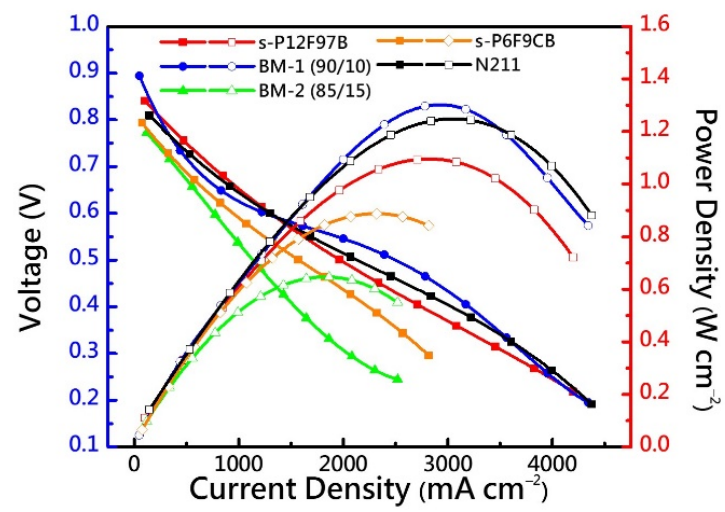
Figure 9. Fuel cell performance of N211and BM-X membranes at 80 ◦ C.